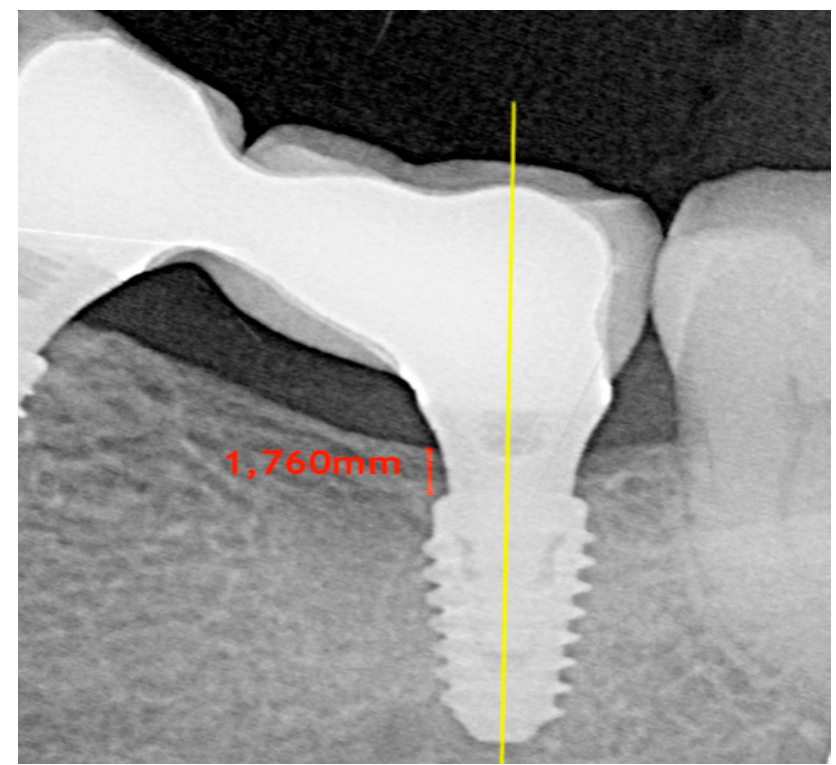
Figure 2. Bone level measurement.